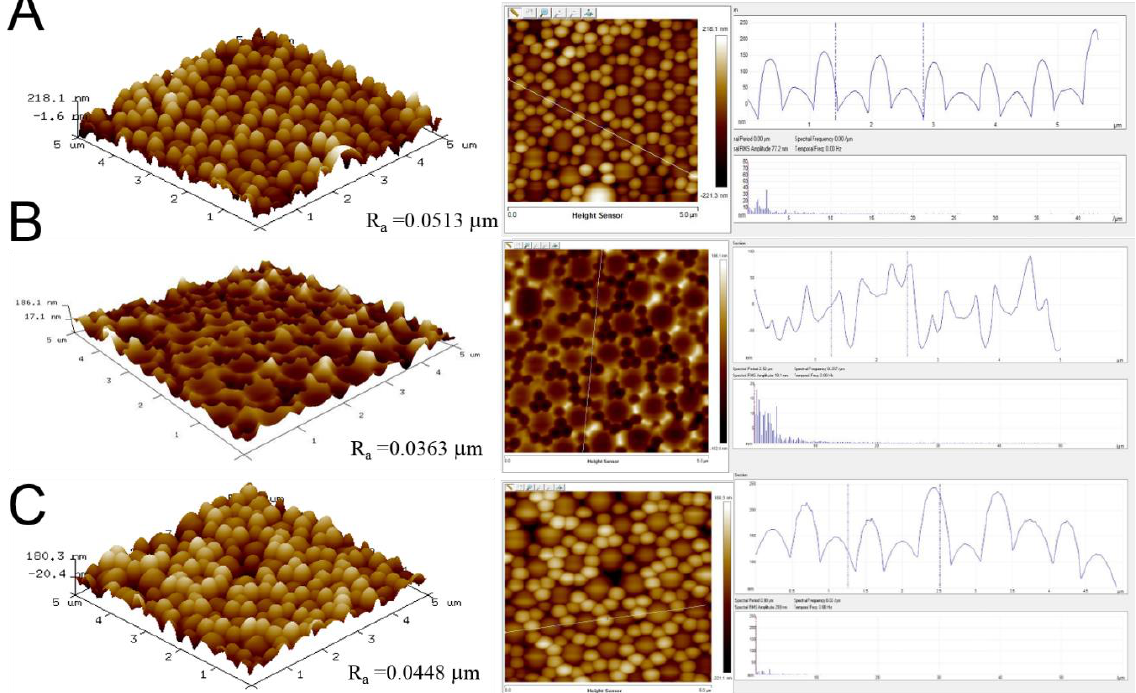
Figure 4. AFM surface morphologies of ( A ) assembled binary nanosphere array, ( B ) replicated soft mold, ( C ) imprinted nanofeatured film.